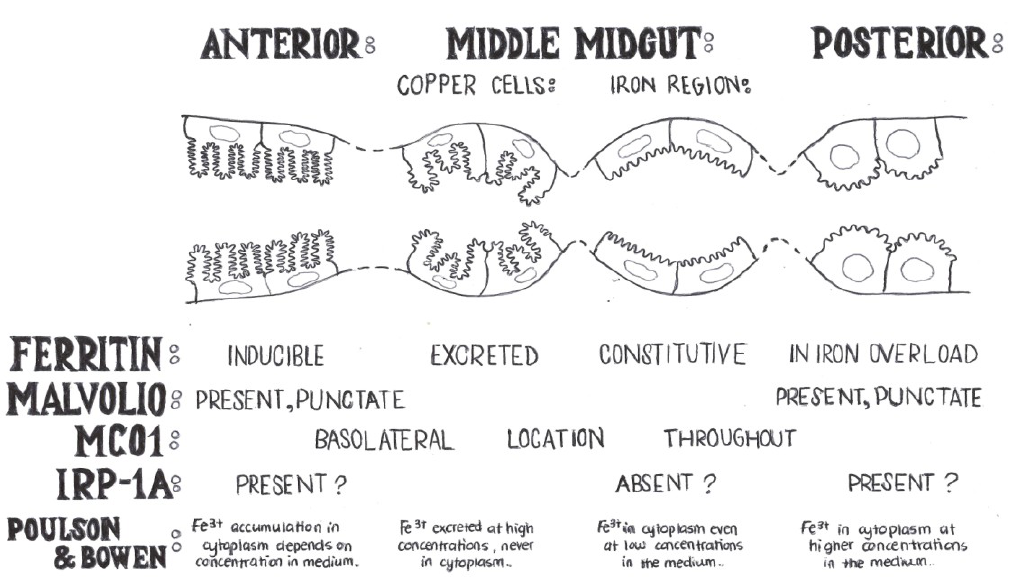
Figure 2. Iron absorption likely takes place in the anterior midgut where all transport proteins studied to date are found. Copper cells are acid-secreting cells, which have also been shown to secrete iron-loaded ferritin in the intestinal lumen. The iron cells express ferritin constitutively and likely serve an iron storage function. Iron cells regulate iron homeostasis independently of IRP-1A and ferritin independently of iron. The posterior midgut appears to be involved with iron homeostasis only in conditions of iron overload. How the different intestinal domains interact with each other remains unknown. For higher resolution images of the different cell types in this diagram the readers are referred to a beautiful representation based on ultrastructure studies performed recently for this tissue [57]. Our diagram is also based on the now 61-year-old study of iron and copper localization in insects [17]. The most posterior part of the midgut (not shown) has no involvement in iron homeostasis, but is a compartment specialized in zinc storage